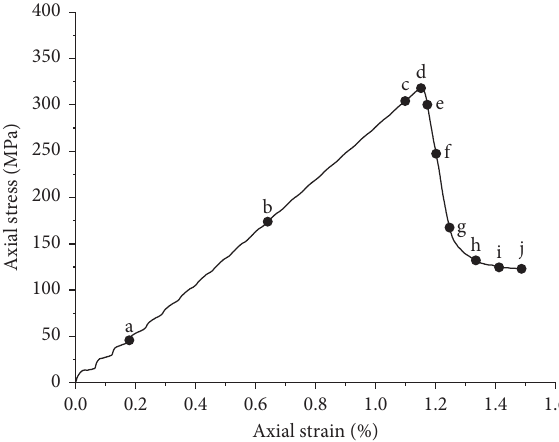
Figure 11: Simulated axial stress-strain curve under confining pressure of 20MPa.